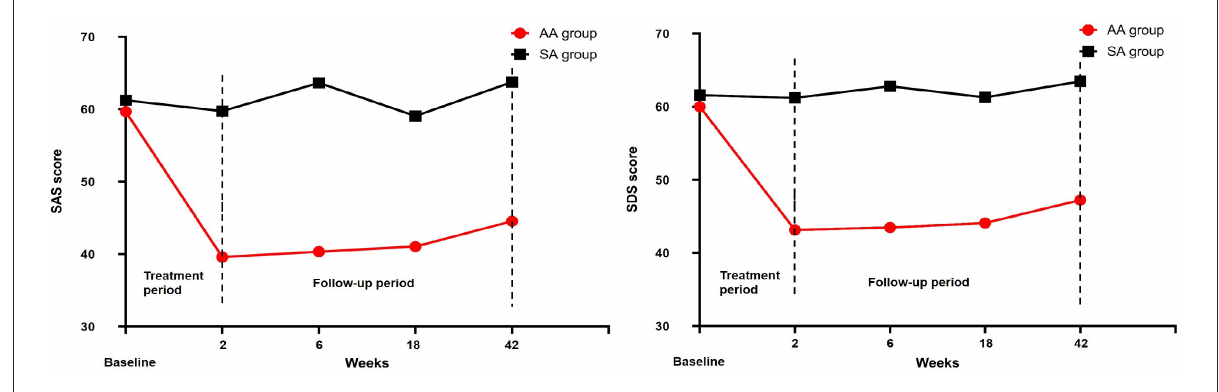
FIGURE6 SAS and SDS scores were compared between the two groups.